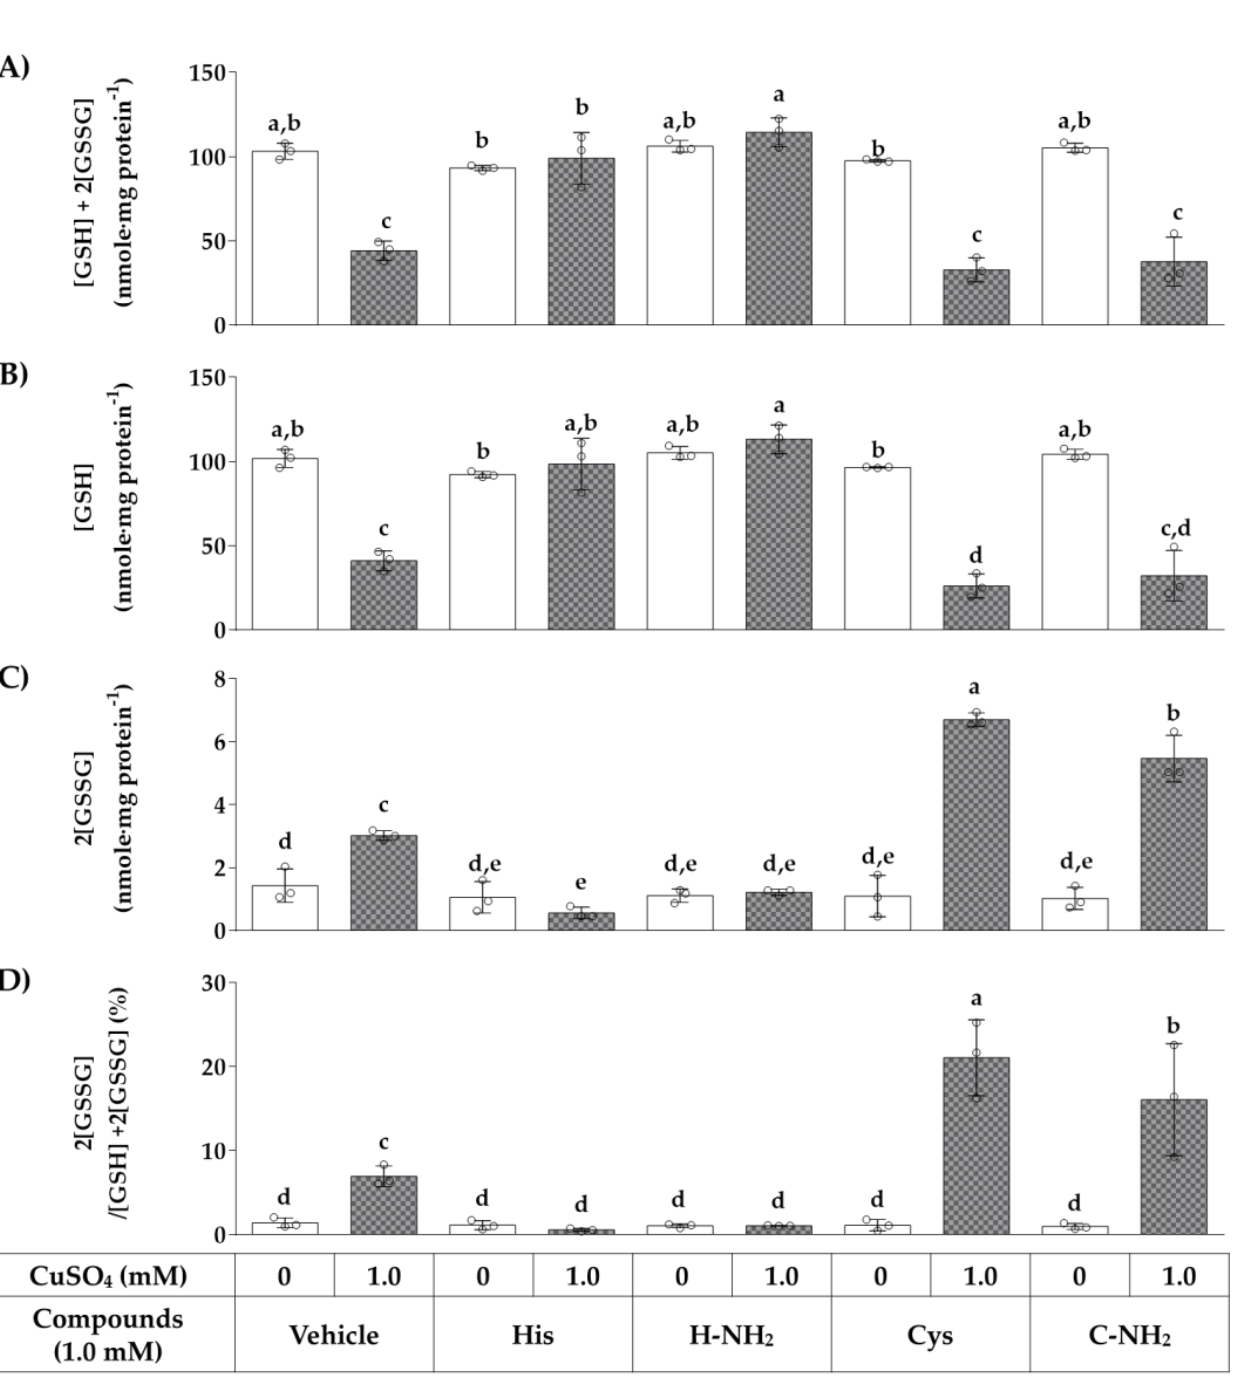
Figure 6. Effects of histidine, histidinamide, cysteine, and cysteinamide on the contents of glutathione (GSH) and glutathione disulfide (GSSG) in HaCaT cells exposed to CuSO 4 . Cells were treated with each compound at 1.0 mM in the absence and presence of 1.0 mM CuSO 4 for 12 h. The total content of GSH plus GSSG ( A ) and that of GSH ( B ) were measured separately using an enzyme-based recycling assay, and the values were used to calculate the content of GSSG ( C ) and the ratio of the oxidized and reduced forms ( D ). Data are presented as mean ± SD (n = 3). Different lowercase letters (a–e) indicate significantly different means at the p < 0.05 level.